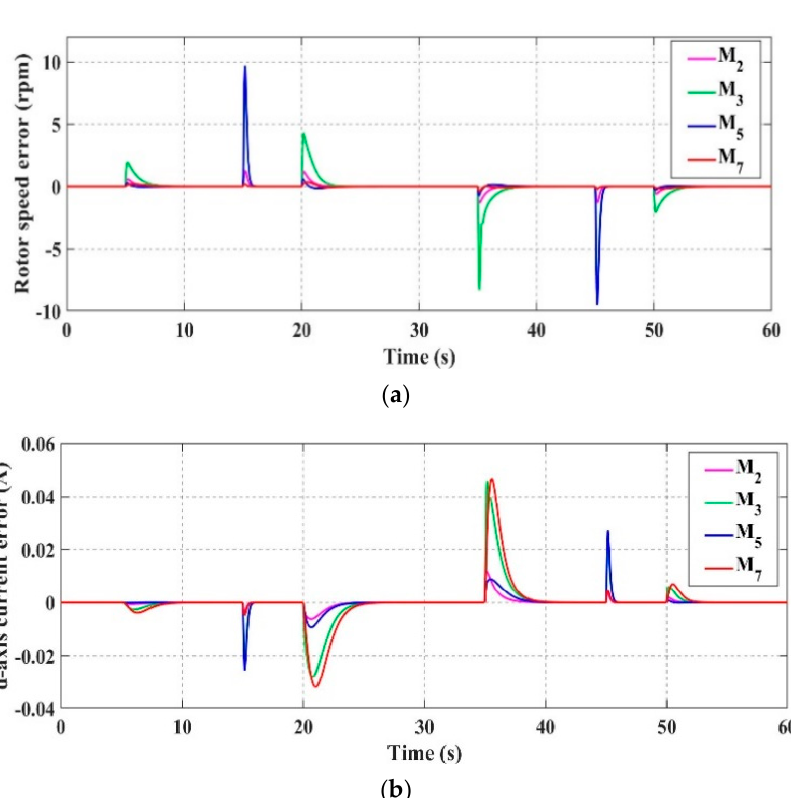
Figure 10. Errors measured in simplified control method. ( a ) Rotor speed error; ( b ) d -axis current error.